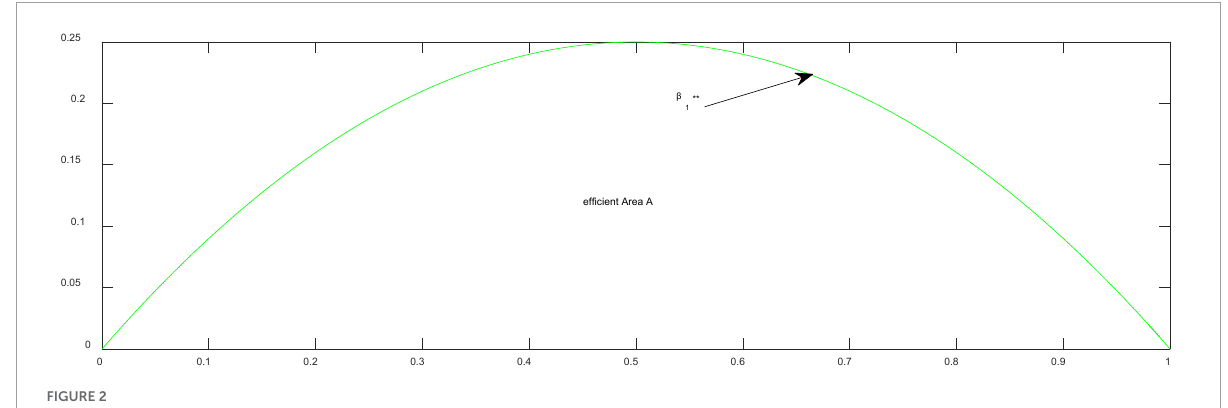
FIGURE2 Changes of efficient boundaries in price competition. **Thresholds of network